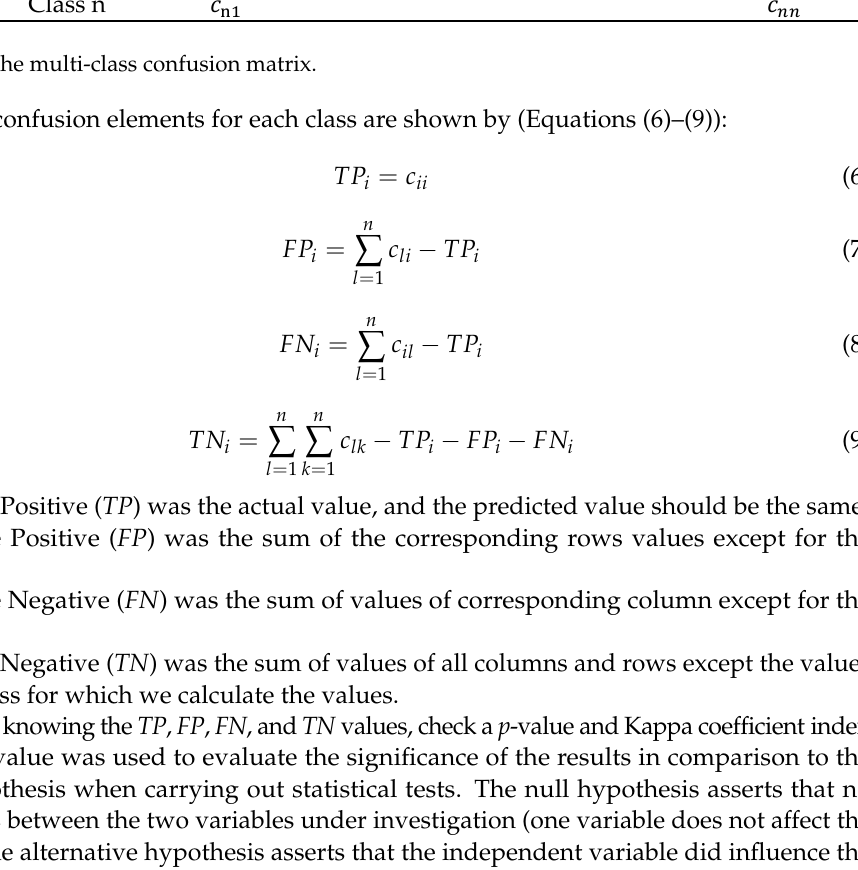
Table 4. The scale of Kappa value